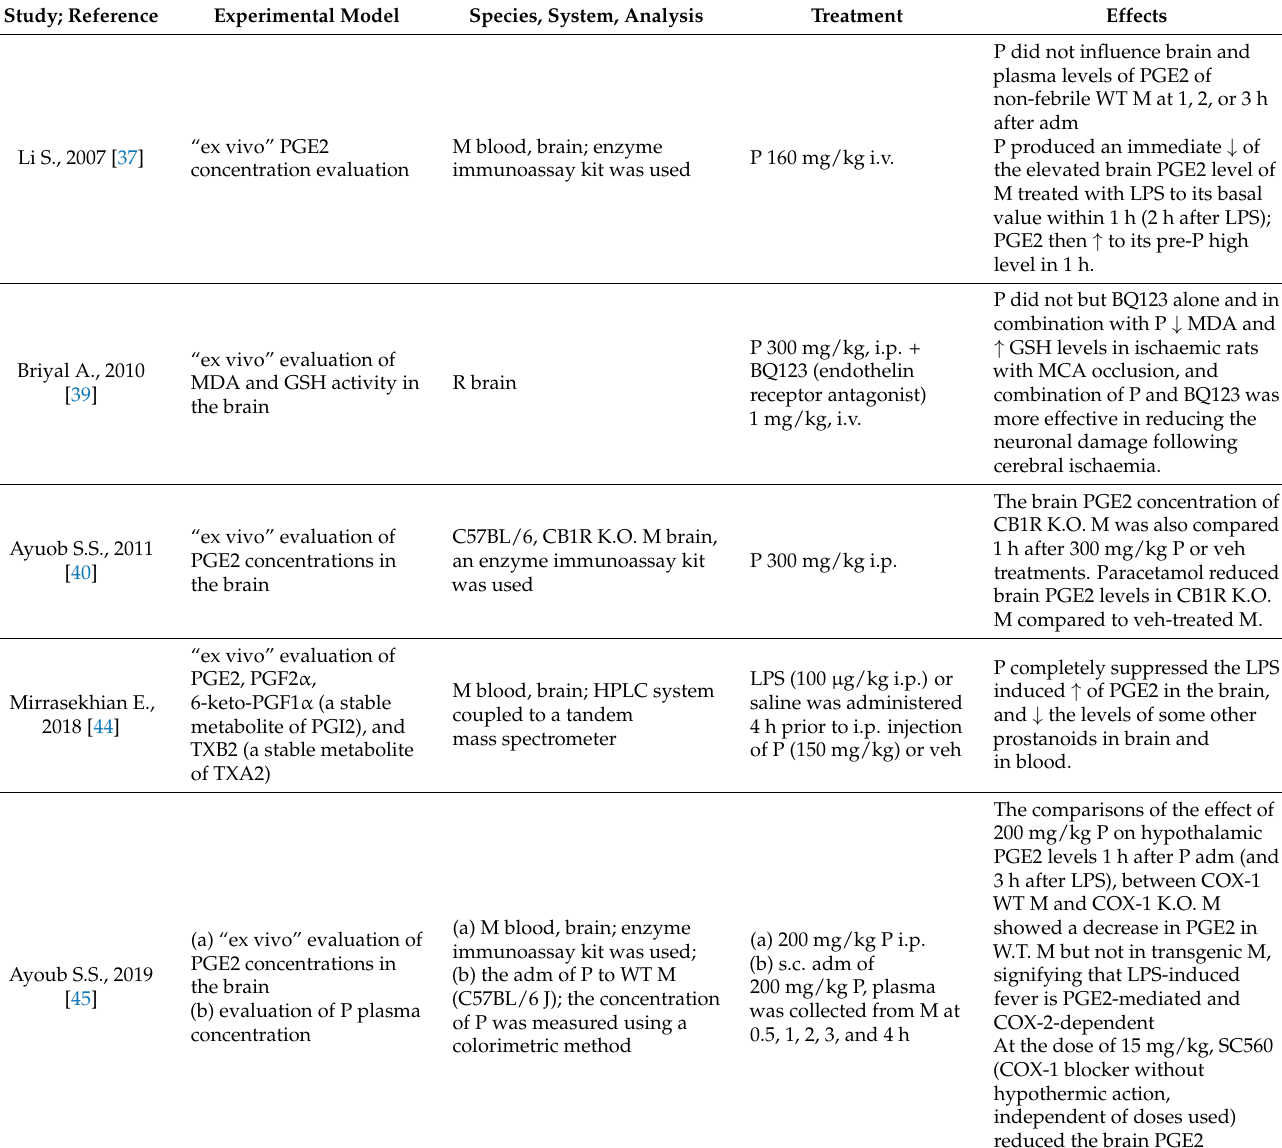
Table 2. Synthesis of the findings of the literature that present paracetamol’s hypothermic effects in vitro/ex